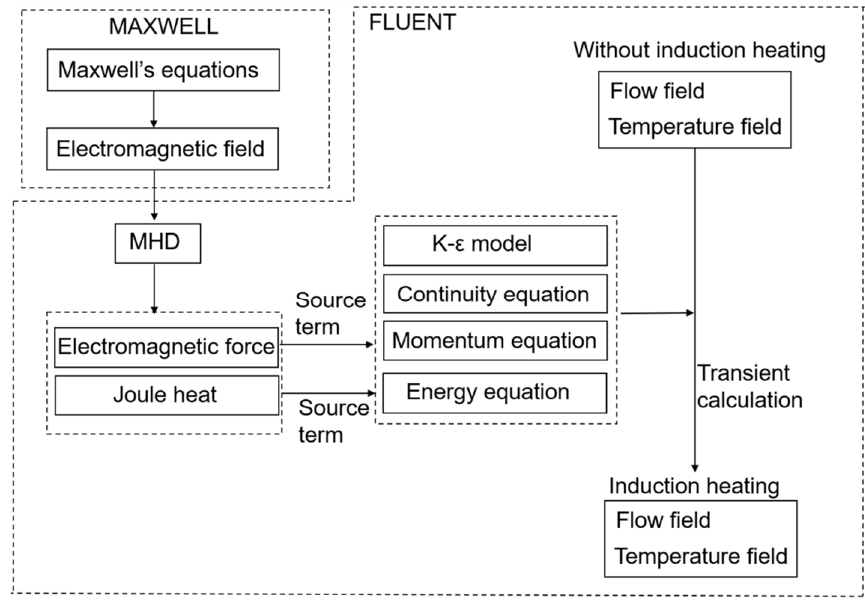
Figure 4. Multi-physics coupling calculation process for the induction heating tundish. MHD: magnetic induction equation.